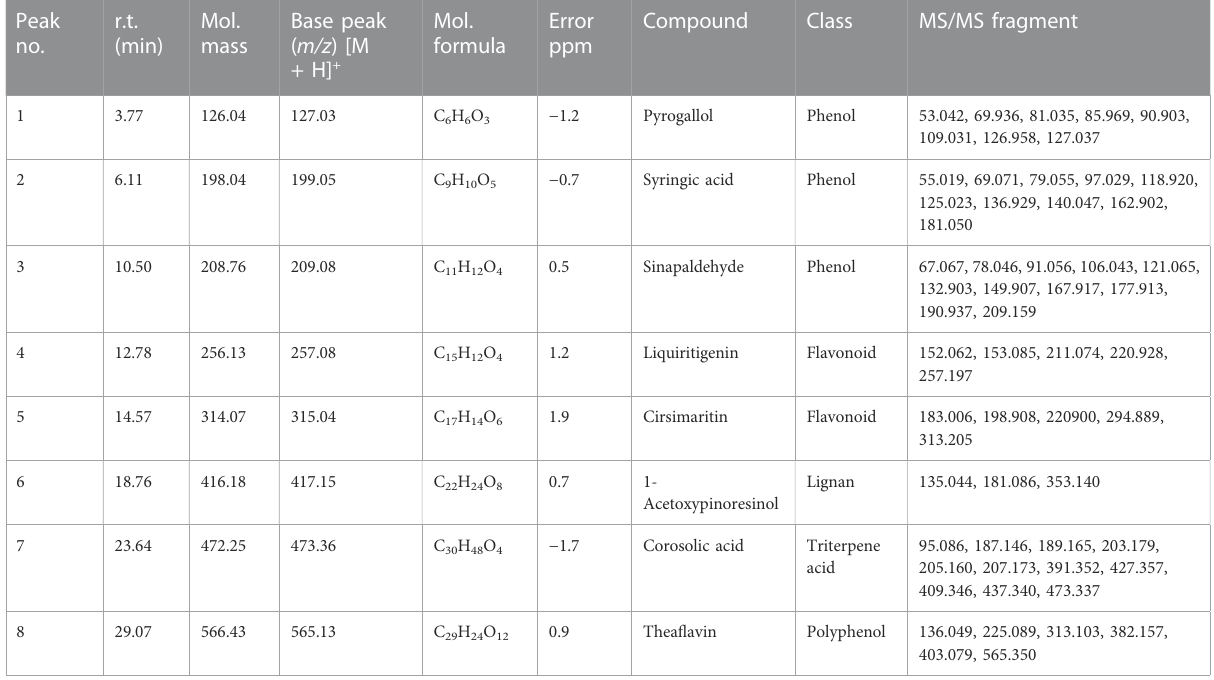
TABLE 1 Tentatively identi fi ed compounds in UPLC-Q-TOF-MS (positive mode) analysis of HAECA. Peak